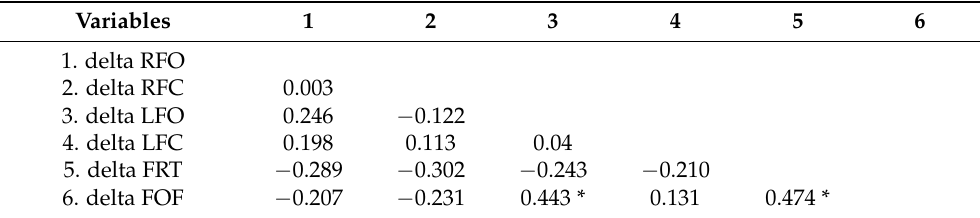
Table 3. Correlations between balance indicators and fear of